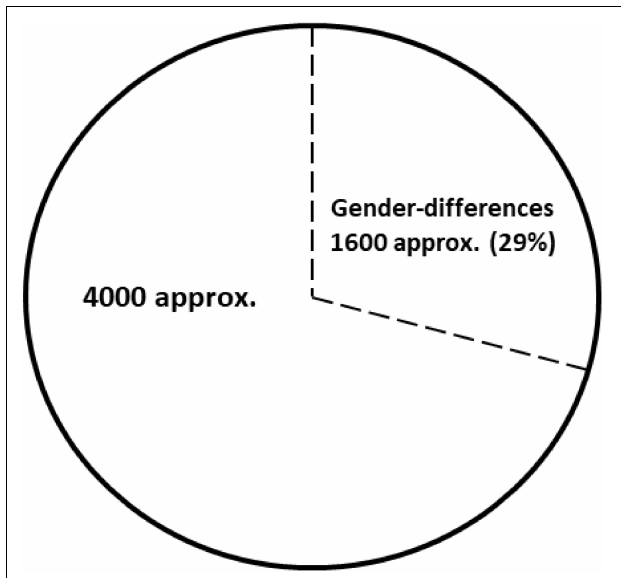
FIGURE 1 | Publications focused on Brugada Syndrome (BrS) (PubMed, January 2022). Of approximate 5,600 publications about BrS near 29% (1,600 publications) included any data concerning female/women or gender/sex